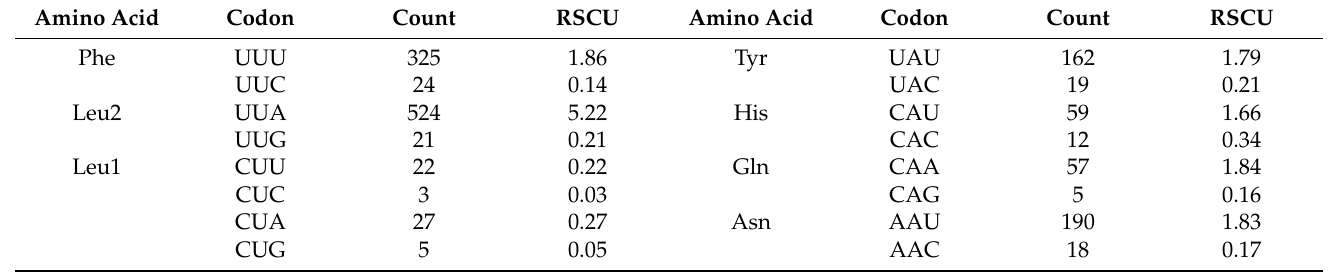
Table 4. Relative synonymous codon usage (RSCU) of Luperomorpha xanthodera mitochondrial PCGs. The asterisk (*) represent Termination